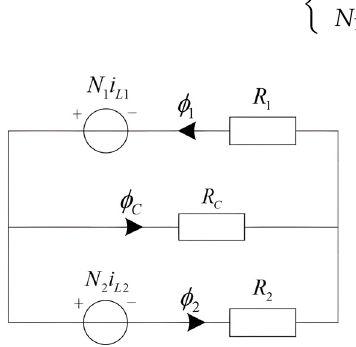
Figure 4. Reluctance model of the proposed circuit.